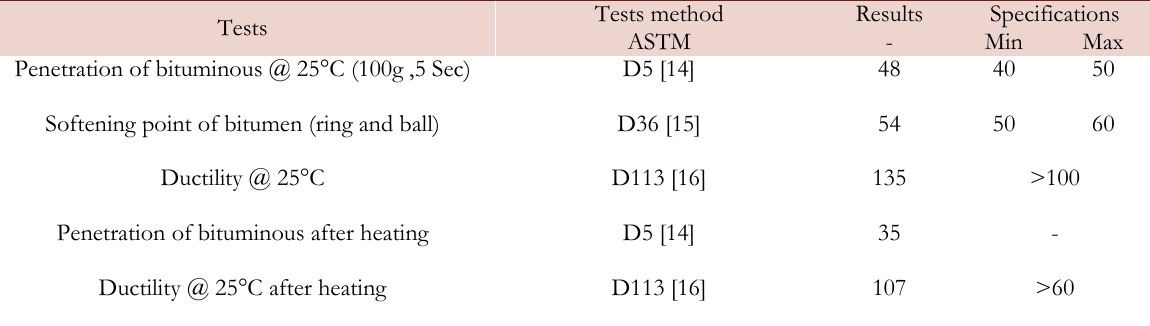
Table 3: Results of asphalt binder